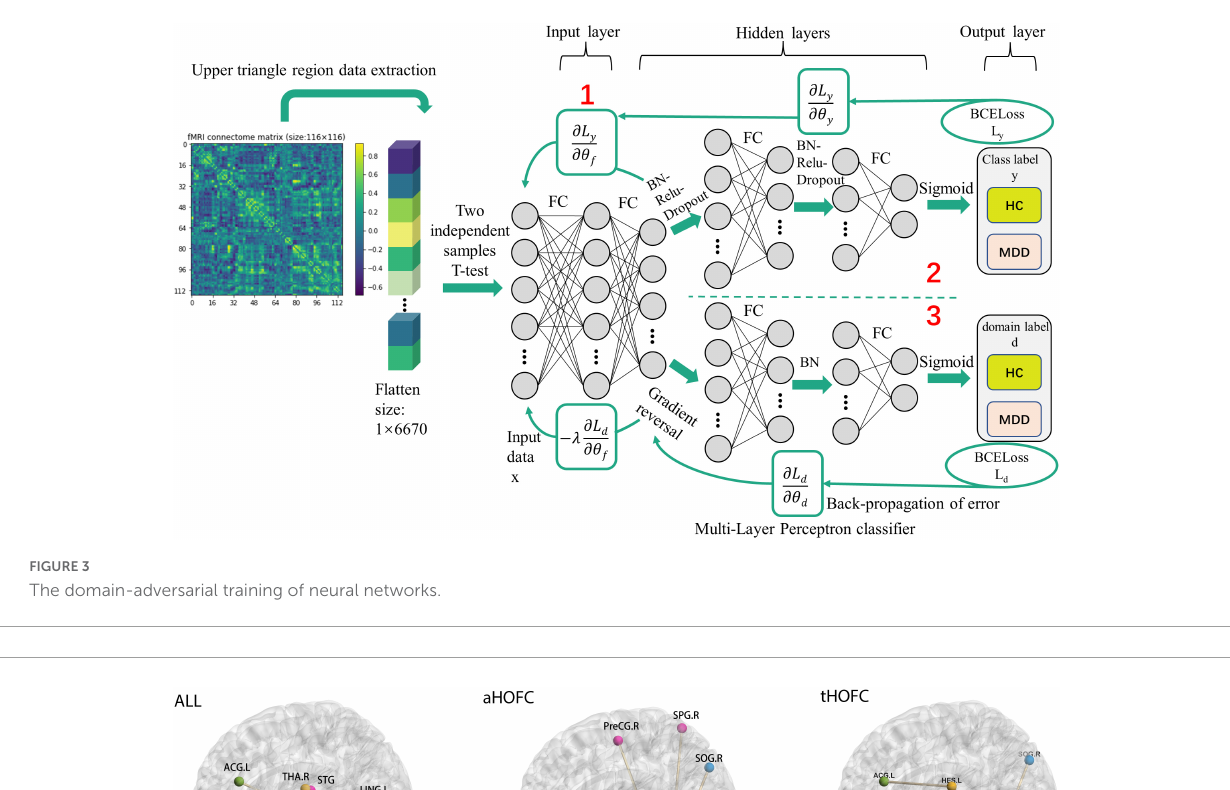
FIGURE4 Features selected for networks. The whole brain was divided into six subnets marked with different colors: (1) DMN; (2) attention network; (3) visual network; (4) subcortical network; (5) cerebellum. The brain networks were visualized with the BrainNet Viewer (Xia et al., 2013); see Table 2 for abbreviations of brain regions on the map.